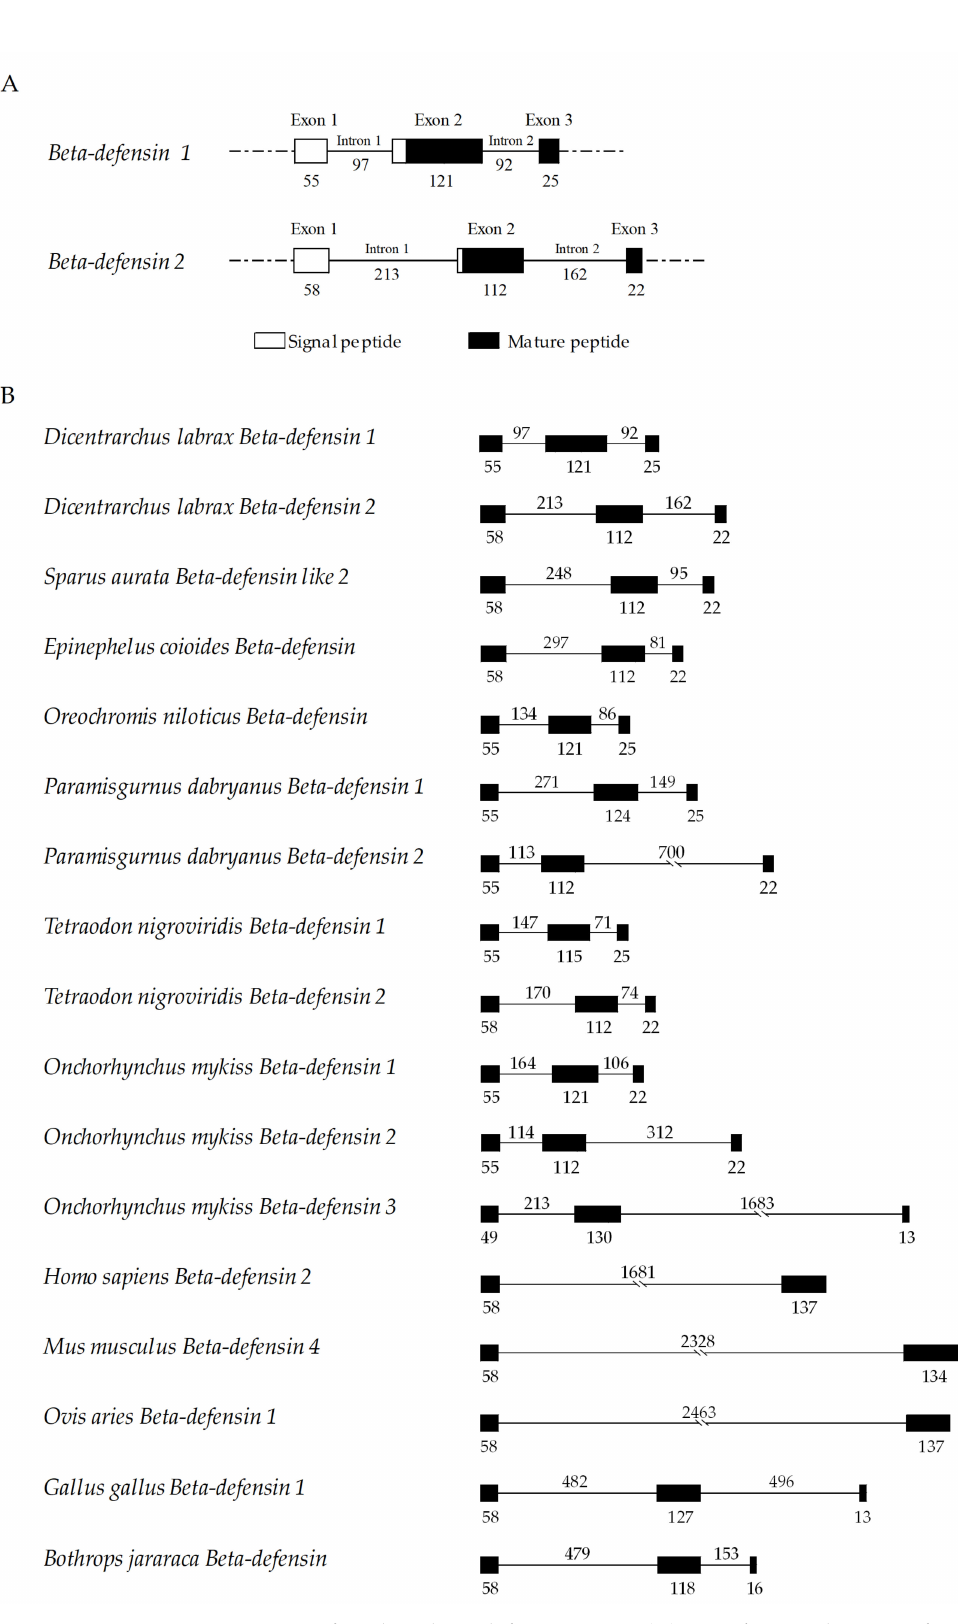
Figure 4. Genomic organization of sea bass beta-defensin genes. ( A ) Exon/intron diagram of sea bass beta-defensin genes. ( B ) Comparative view with other vertebrate beta-defensins. Exons are shown as boxes and introns as solid lines, with sizes of exons/introns in base